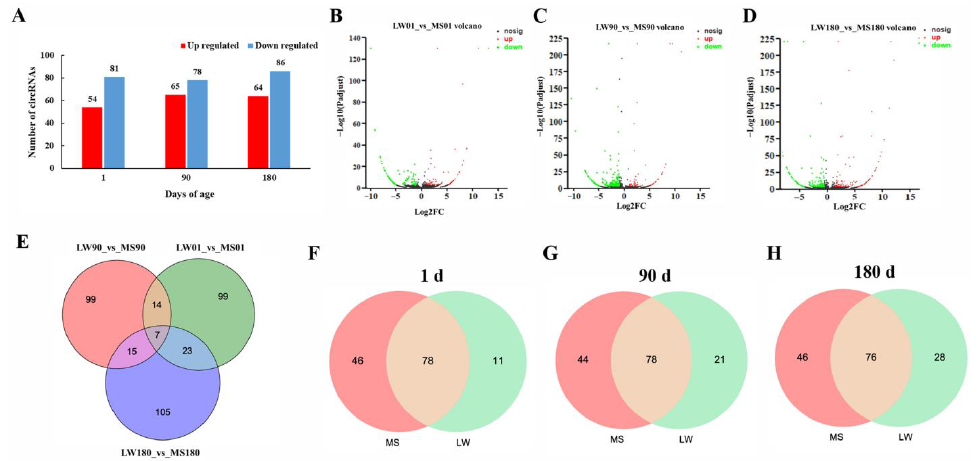
Figure 1. DEcircRNA analysis between two breeds. ( A ): Numner of DEcircRNAs. ( B – D ): Volcano plot of DEcircRNAs at 1, 90, and 180 days of age, respectively. ( E ): Venn diagram of DEcircRNAs. Int. J. Mol. Sci. 2022 FOR PEER REVIEW ( F – H ): Venn diagram showing the expression specificity of DEcircRNAs between the two pig species. An enrichment analysis showed that the host genes of DEcircRNAs at 1 day of age were mainly enriched in cellular senescence, the Hippo signaling pathway, and antigen processing and presentation (Figure 2A,D); those at 90 days of age were mainly enriched in the TGF-beta signaling pathway and endocytosis (Figure 2B,E); and those at 180 days of age were mainly enriched in propanoate metabolism and the TGF-beta and Hippo signaling pathways (Figure 2B,E).